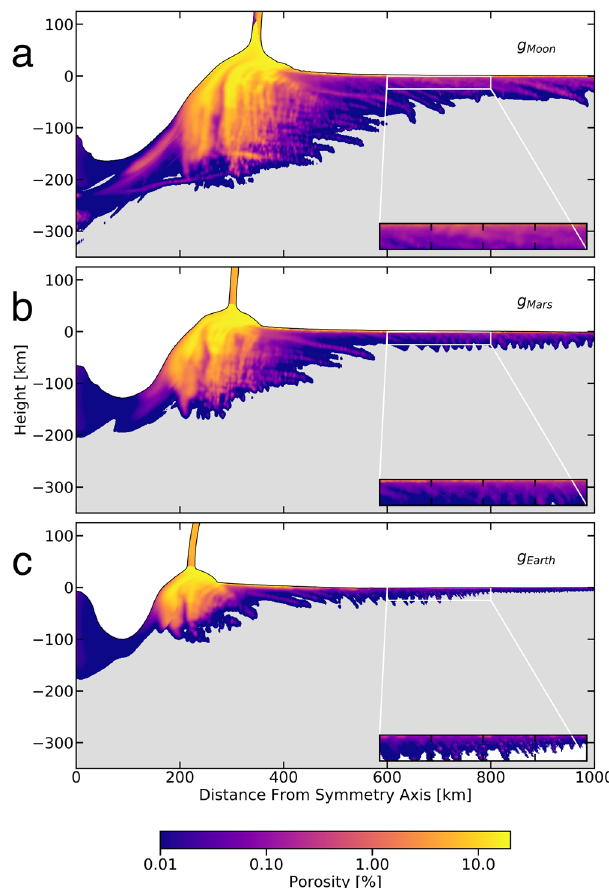
Fig. 3 | Porosity results for different gravities. Results of 100km diameter impactor striking asurfaceunderlunar( a ),martian( b ),and Earth ( c )gravities. The three frames correspond to the color bar with all gray material representing non- porous material. In each panel the zoomed box is the area from 600 to 800km in the X direction, and 0 to − 25 kminthe Y direction. Within these zoomed boxes the white material is non-porous material. Space averaged porosity pro fi les from each of these runs are given in Fig. 4.